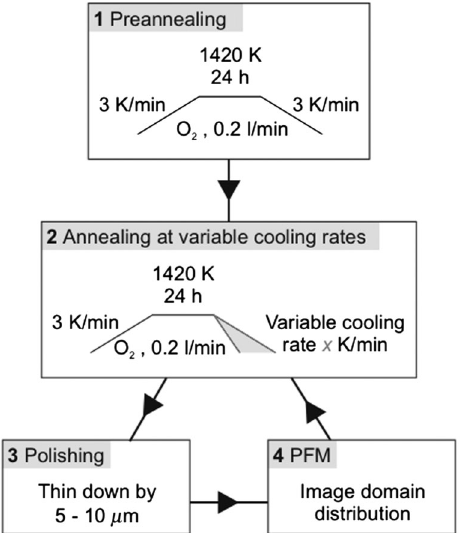
FIG. 5. Sketch of the annealing procedure. After preannealing, the samples are heated to 1420 K with a hold time of 24 h and subsequent cooling at rates between 0.1 and 1360 K = min . After the annealing cycle, the samples are thinned by 5 – 10 (cid:5) m by polishing in order to access the domain structure formed in the true three-dimensional bulk of the